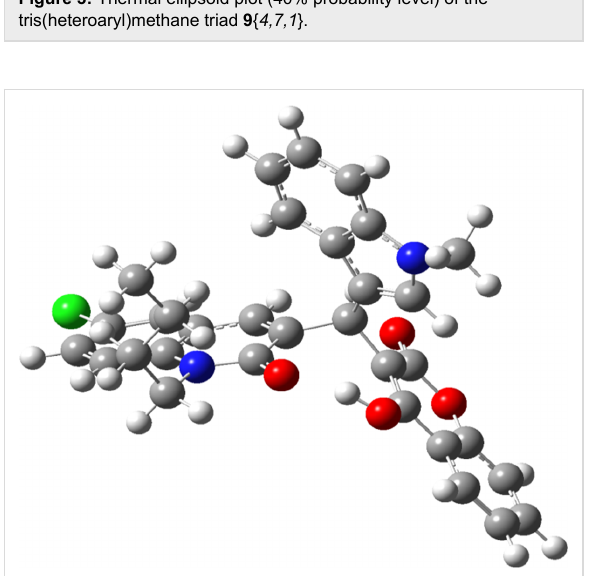
Figure 4: DFT-optimized structure of 9 { 4,7,1 } triad.